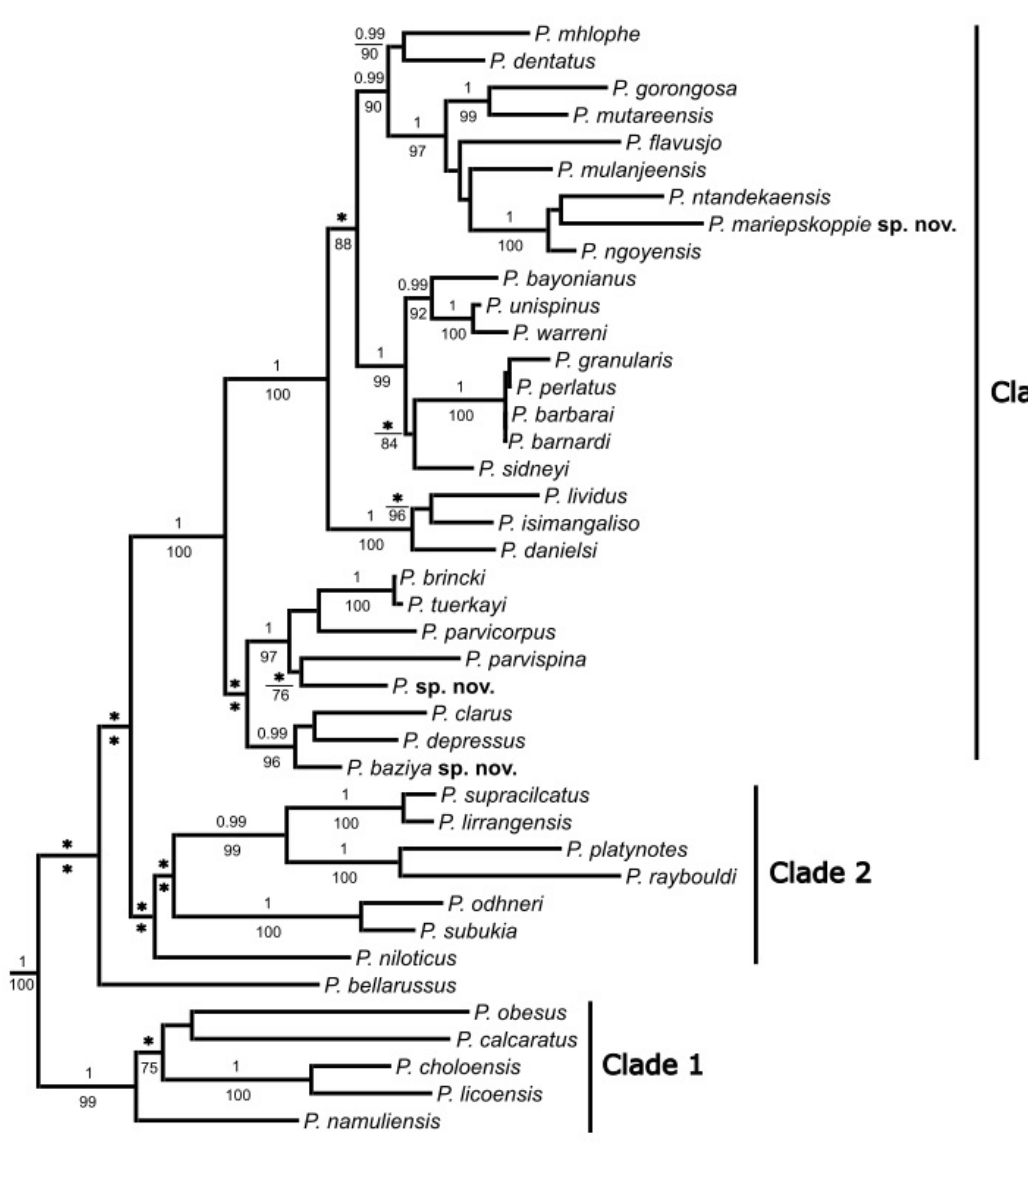
Fig. 1. A Maximum Likelihood tree topology derived for the three mtDNA loci (12S rRNA +16S rRNA + COI) for the eastern and southern African freshwater crab genus Potamonautes , with the outgroups removed. Bootstrap values > 75% are indicated below each node while posterior probability values > 0.95 p P are shown above each node. An asterisk (*) above or below a node indicates the lack of statistical support. The new, as yet undescribed species from Hogsback is demarked as P . sp. nov. on the phylogenetic tree. Clades 1 and 2 refers to predominantly East African species, while clade 3 refers to the southern African